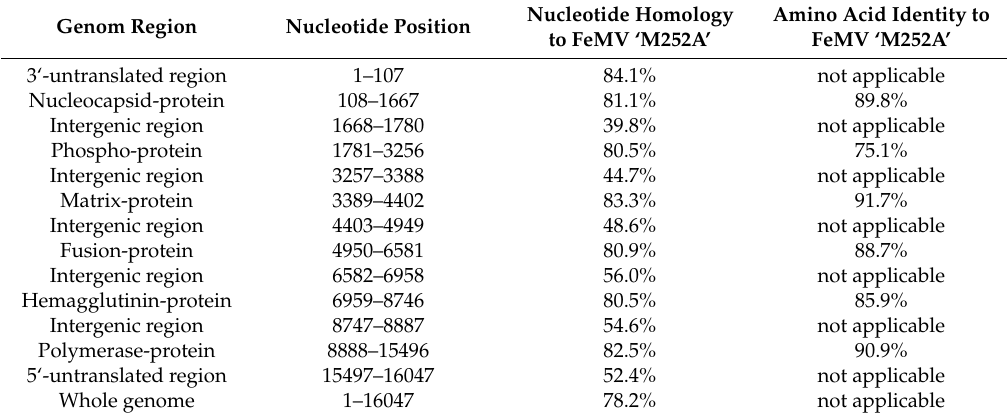
Table 3. Whole genome comparison between FeMV and FeMV-GT2-Gordon strain *.